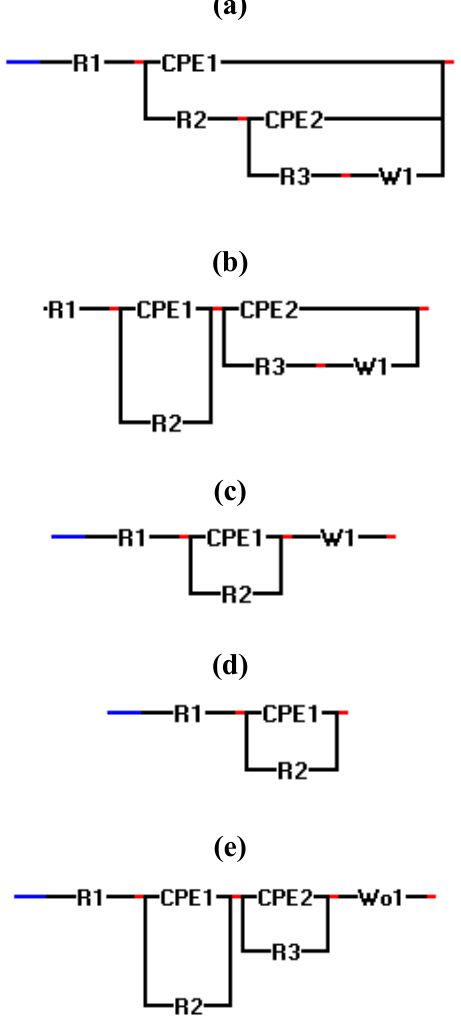
Figure 8. Electrochemical equivalent circuits to fit the EIS